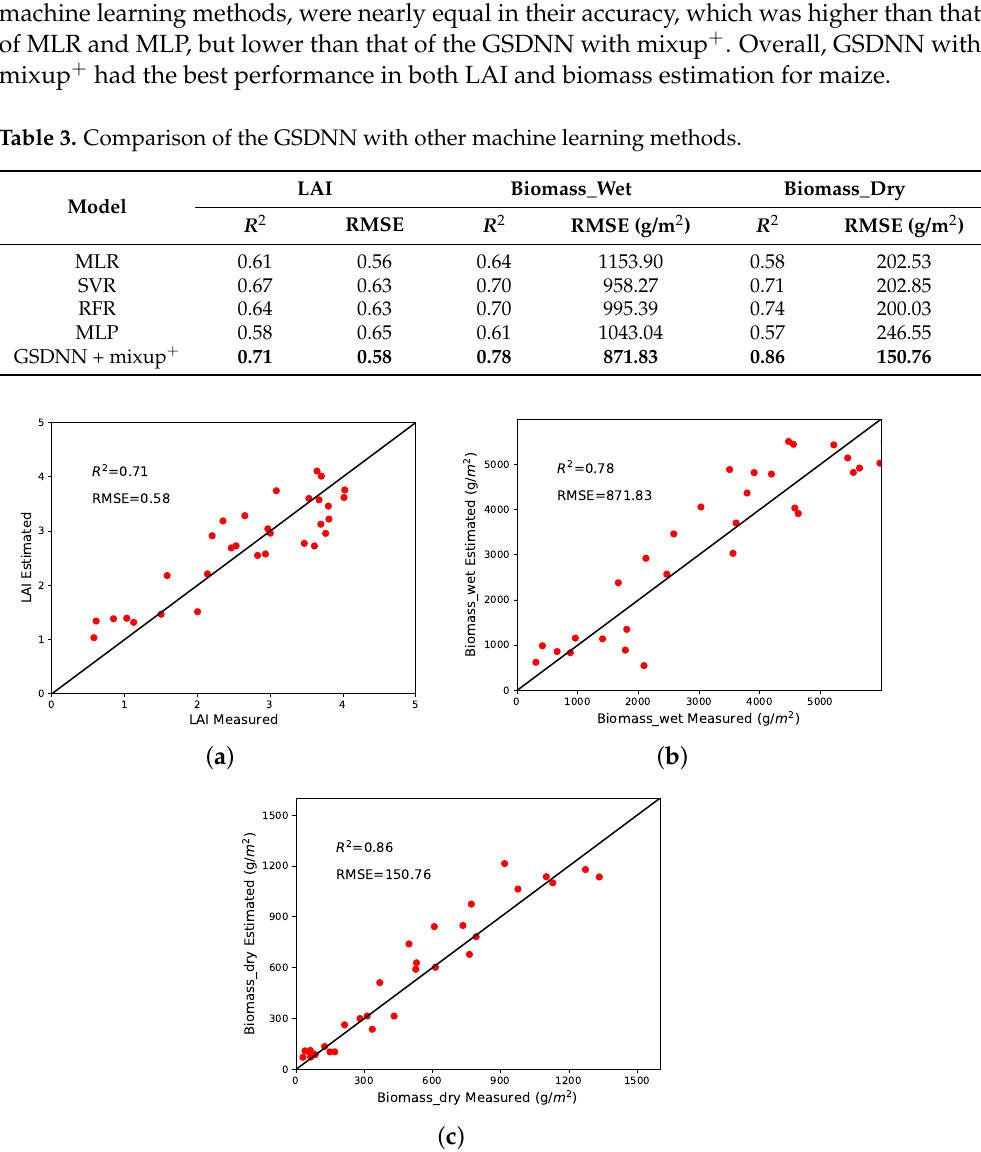
Figure 4. Comparison of the measured values with estimates from the model based on the GSDNN: ( a ) LAI; ( b ) Biomass_wet; ( c )